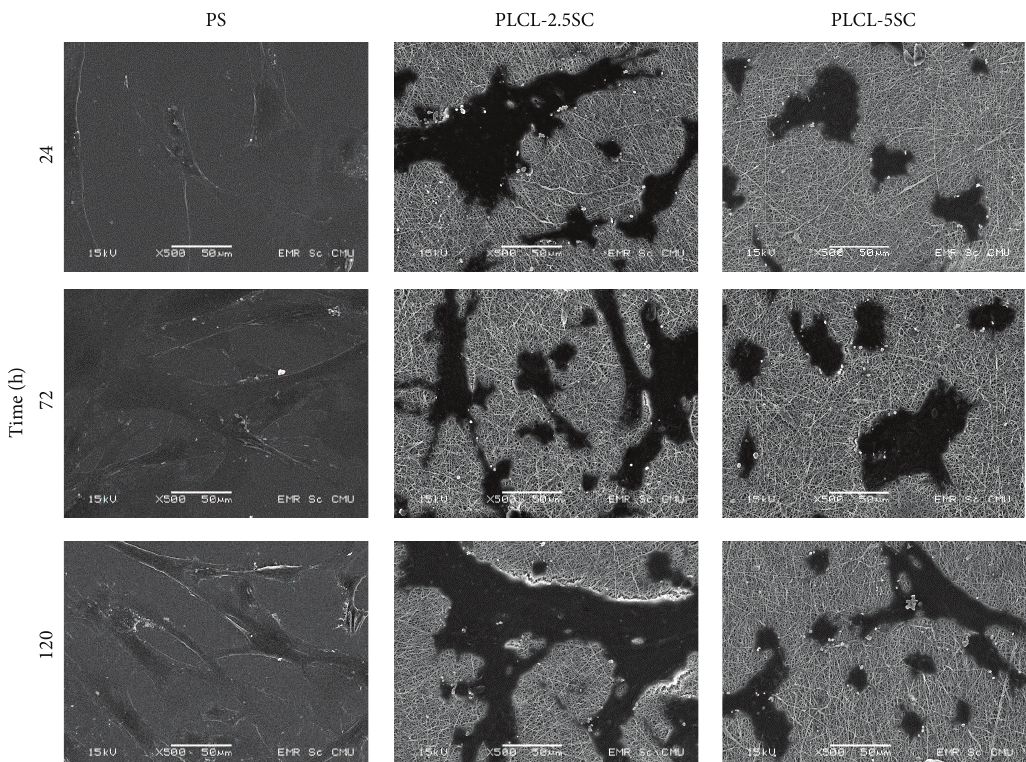
Figure 14: Photomicrographs from SEM showing the morphology and proliferation pattern of BCP-K1 on PS, PLCL-2.5SC, and PLCL-5SC membranes, cultured at 24, 72, and 120 hours. The power of magnification is 500x at 15 kV (scale bar 50 𝜇